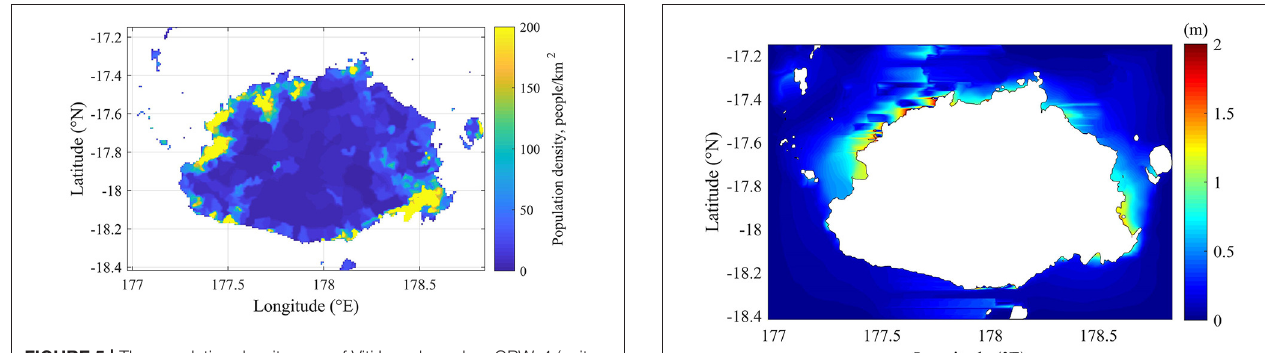
FIGURE 5 | The population density map of Viti Levu based on GPWv4 (unit: a number of people/km 2 ).